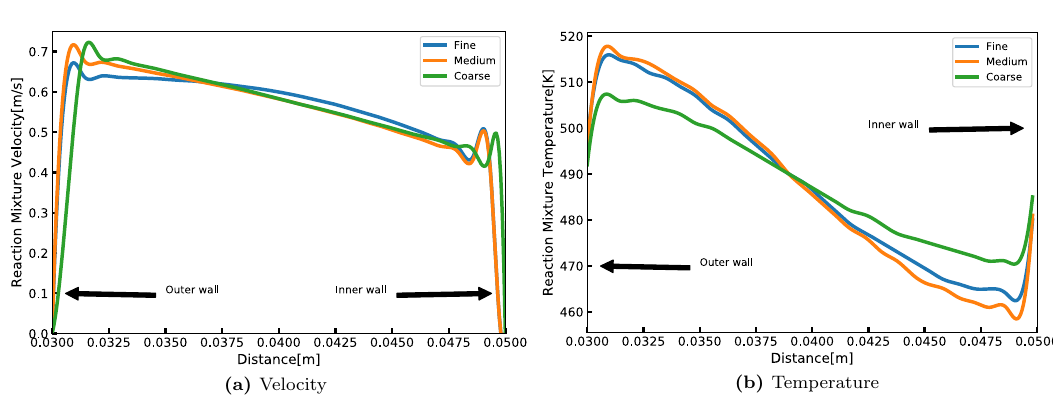
Figure 3. Grid independence results of centerline profiles at the end of the first spiral turn: ( a ) velocity, and ( b )